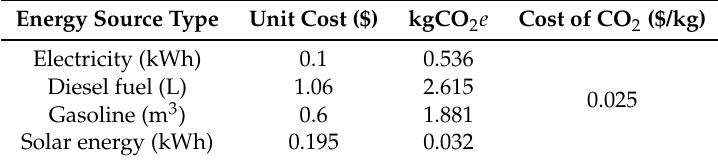
Table 5. Energy cost and carbon emissions.